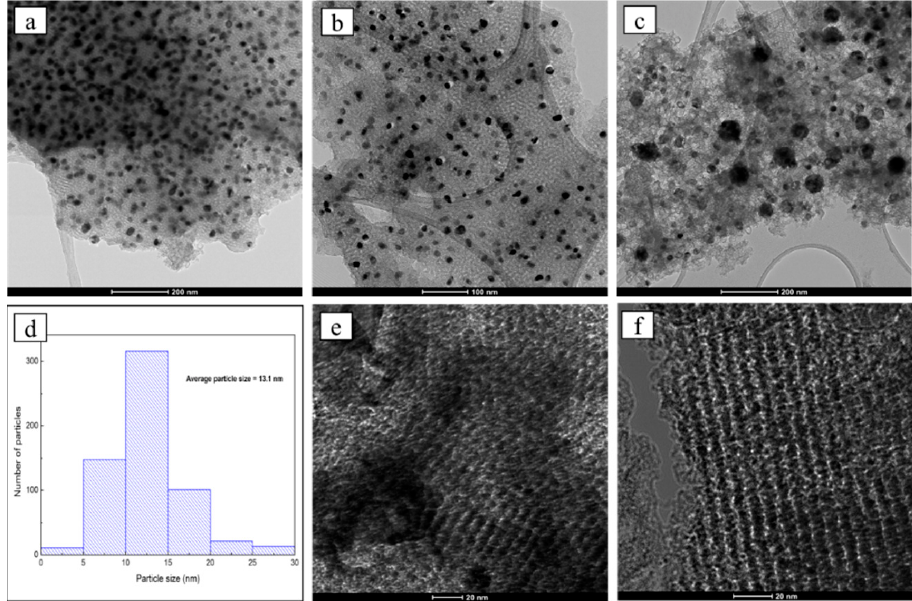
Figure 1. High-resolution TEM images of TPNi ( a – c , e , f ) and average nickel particle size distribution for TPNi ( d ).